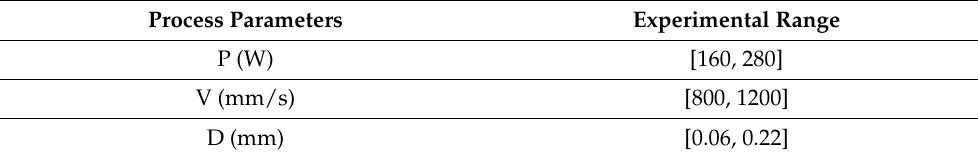
Figure 3. ( left ) Tensile Test Specimen Dimensions, ( right ) the as-built part. Table 2. The Experimental